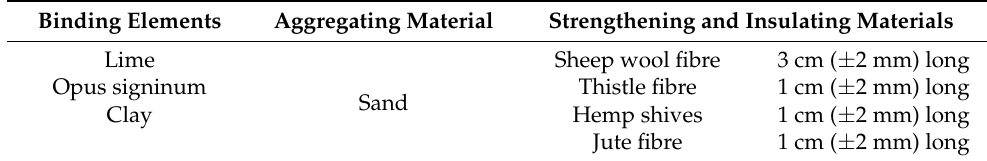
Table 1. Ingredients involved in the samples’